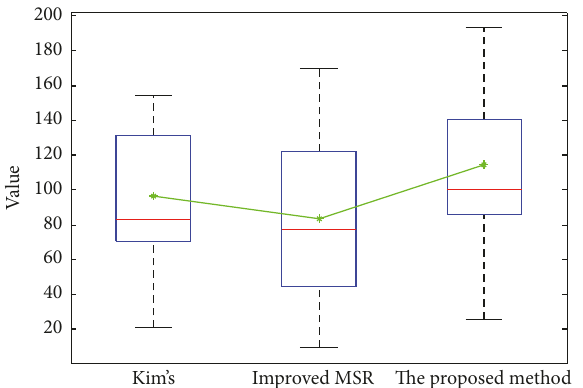
Figure 14: AEI results by Kim’s, improved MSR, and the proposed method.